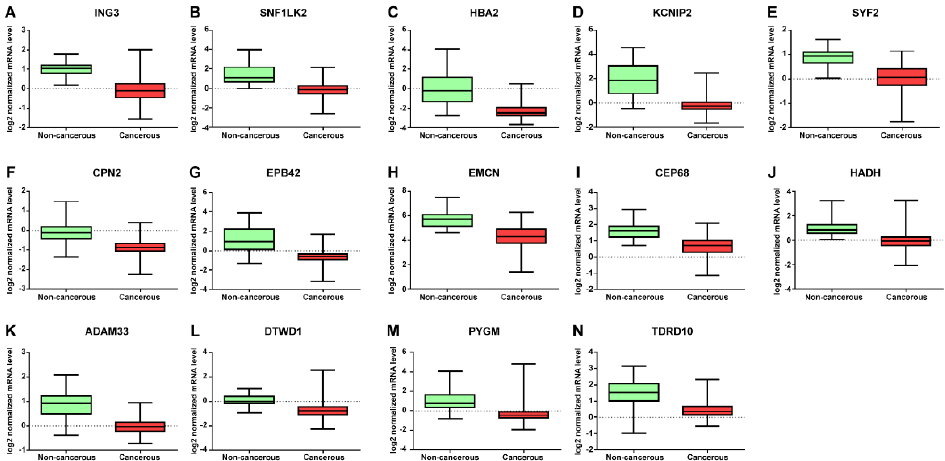
Figure 3. Expression levels of downregulated mRNA in breast cancer tissues. 14 differentially expressed (DE) mRNA profile data with p < 0.001 values. ( A ) ING3, ( B ) SNF1LK2, ( C ) HBA2, ( D ) KCNIP2, ( E ) SYF2, ( F ) CPN2, ( G ) EPB42, ( H ) EMCN, ( I ) CEP68, ( J ) HADH, ( K ) ADAM33, ( L ) DTWD1, ( M ) PYGM, and ( N ) TDRD10.